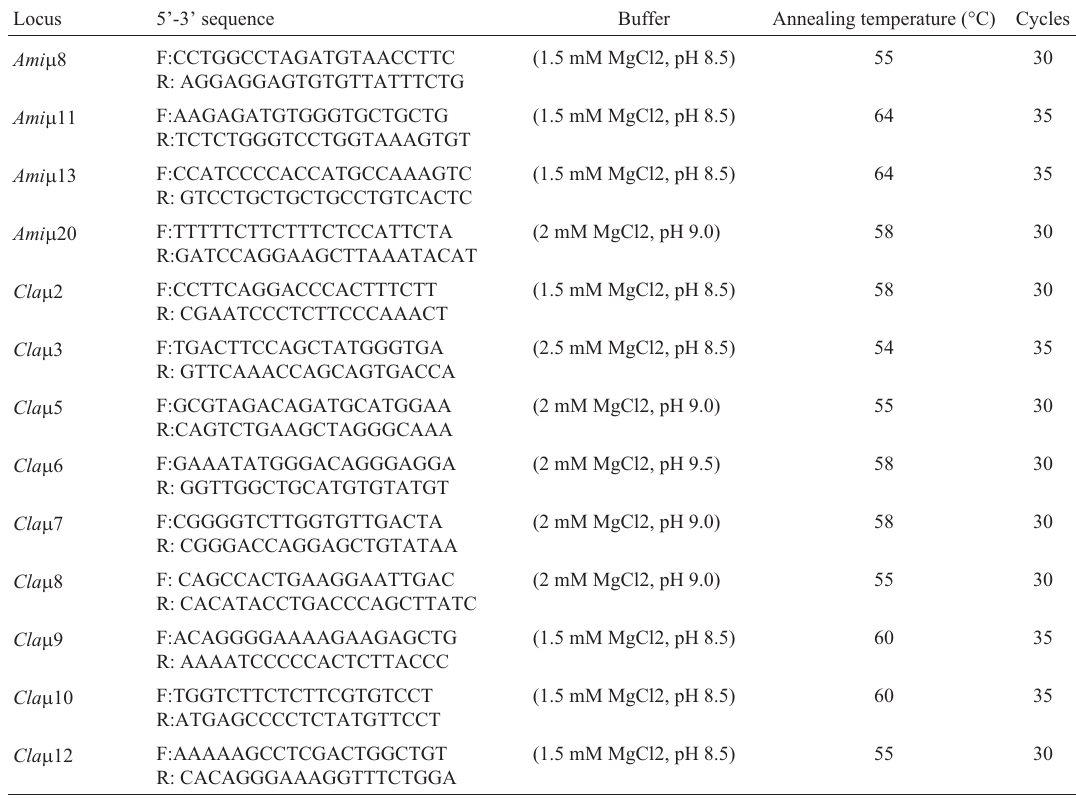
Table 1 - Primers and amplification